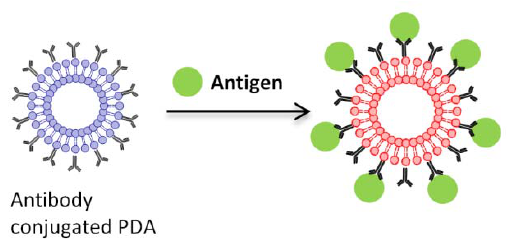
Figure 12. Blue to red color transition upon ligand binding to the receptor conjugated to the head group of PDA (drawn with ChemDraw, PerkinElmer,